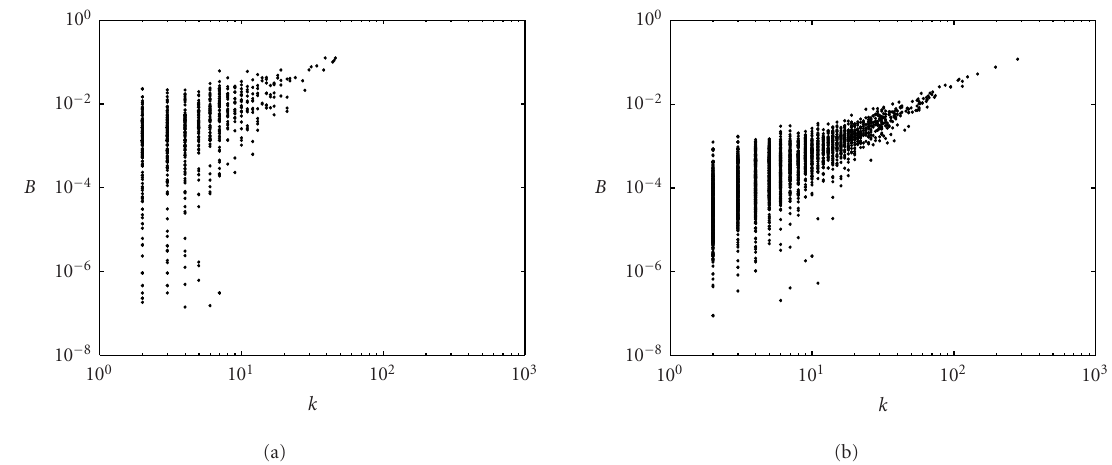
Figure 1. Degree ( k ) versus betweenness ( B ) plotted in logarithmic scale for the measured yeast interaction network based on DIP data [15, 16]. (a) Core data. (b) Full DIP